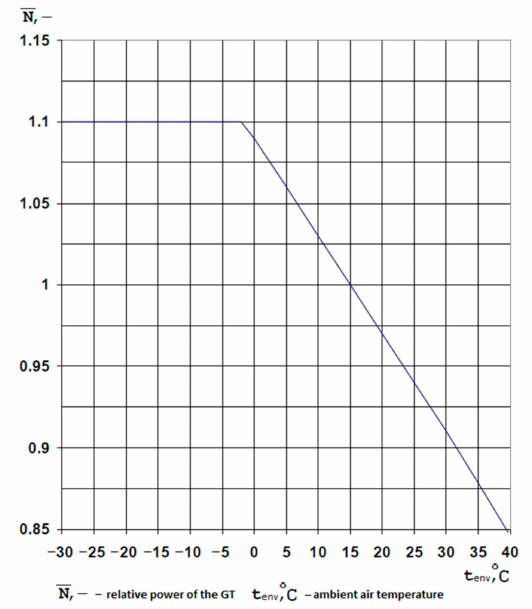
Figure 3. Dependence of the relative power of the GT on the ambient air temperature [28].